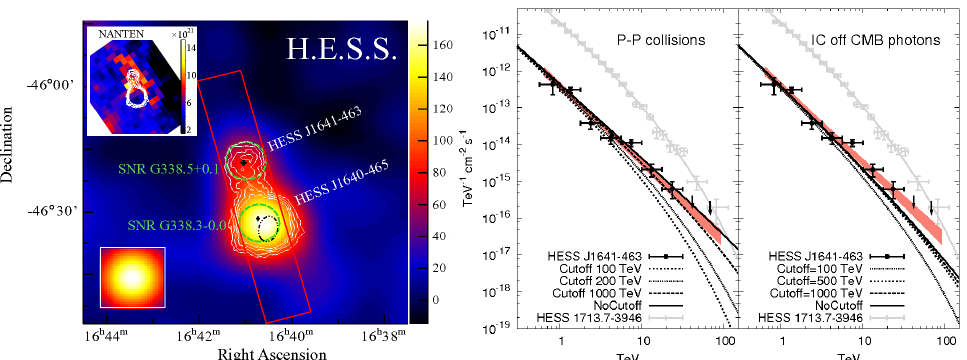
Figure 6. On the left: The H.E.S.S. emission from the region of the hard spectrum source, HESS J1641-463, hosting the nearby bright SNR, SNR G338.3-0.0, coincident with HESS J1640-465. In the bottom insert, the H.E.S.S. PSF is presented, while the upper insert shows the gas distribution in the region according to the NANTEN CO survey [70]. Cosmic rays leaking from G338.3-0.0 and interacting with dense molecular clouds is the most likely scenario to explain the TeV emission detected from HESS J1641-463. HESS J1641-463 has one of the hardest spectra ever detected in TeV astronomy, extending up to 30 TeV without evidence of a cut-off (see the right panel ). The differential VHE gamma-ray spectrum of HESS J1641-463 for energies between 0.64 TeV and 100 TeV, together with the expected emission from p–p collisions (left) and IC from CMB photons (right) is shown in the right panel . The pink area represents the 1- σ confidence region for the fit to a power law model, the red data points to the H.E.S.S. measured photon flux (1- σ uncertainties), the arrows the 95% CL upper limits on the flux level, and the black curves the expected emission from the models, assuming different particle energy cut-off values. For comparison, the gray data points and curves represent the archival spectrum and the corresponding best fit model, respectively, of the young SNRRX J1713.7-3946 [71] The two plots are from